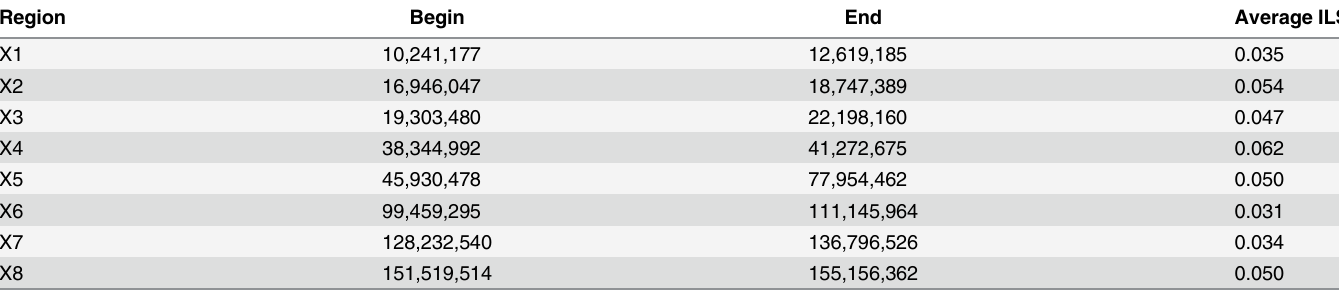
Table 1. Low-ILS regions on the X chromosome. Coordinates are given according to the Human genome hg19. Region Begin End Average